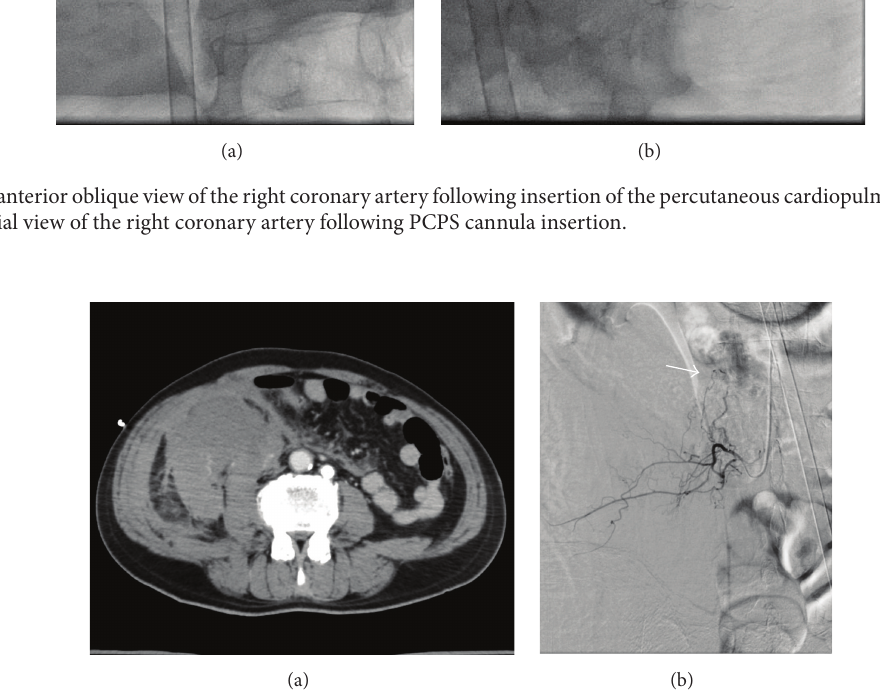
Figure 6: (a) Computed tomography of the abdomen revealed a large hematoma in the right abdomen. (b) Selective angiography revealed bleeding (arrow) from the right lumbar